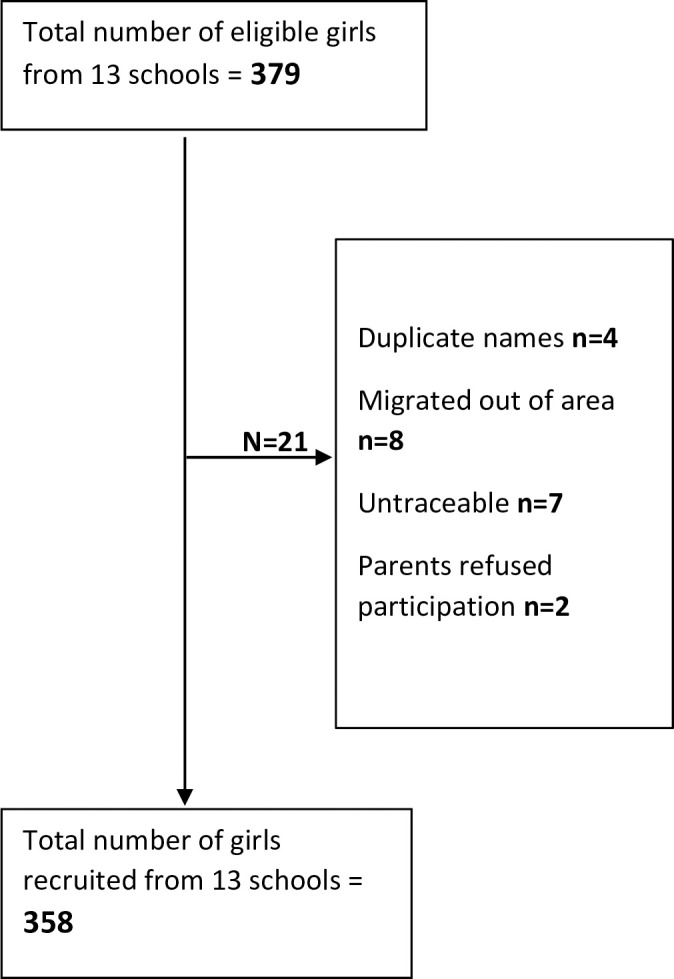
Flow diagram of the sampling process.